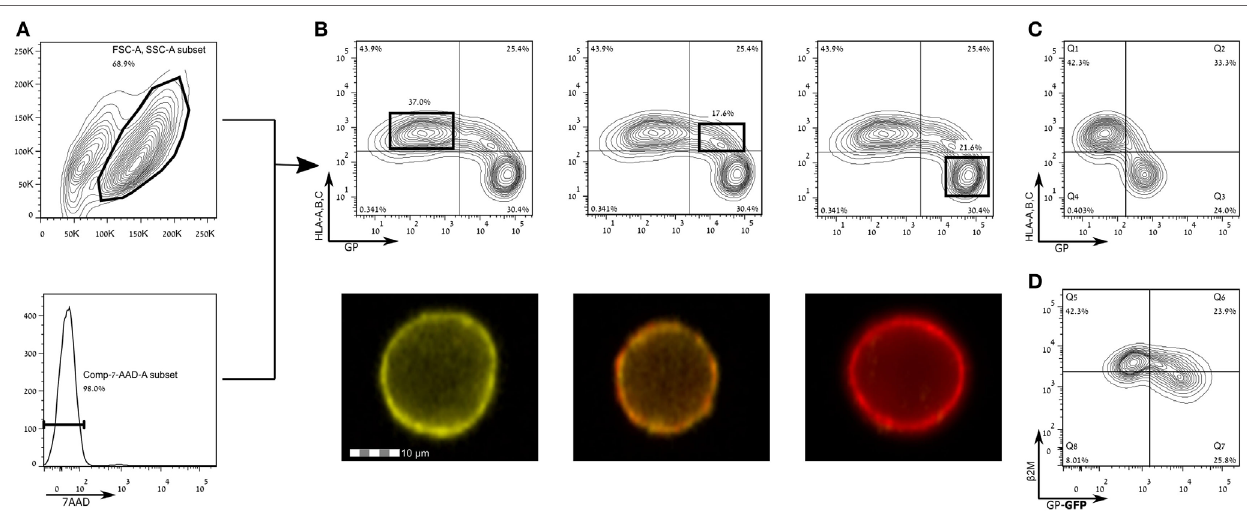
FigUre 2 | Expression of Sudan virus (SUDV)- and Makona-GPs results in loss of surface staining of HLA-A, B, C. The figure shows flow cytometry analysis of steric shielding of HLA-A, B, C antigens by Ebola GP. (a) SUDV-GP transfected HEK293T cells were harvested using a non-enzymatic reagent, and dead cells were excluded by 7-aminoactinomycin D. (B) Cells were stained for SUDV-GP with a biotinylated 3C10 antibody, followed by allophycocyanin-conjugated streptavidin, and co-stained for HLA-A, B, C surface antigens with a phycoerythrin-conjugated W6/32 antibody. Representative examples are shown in image stream fluorescent microscopy (Yellow: HLA-A, B, C. Red: SUDV-GP). (c) Makona-GP-transfected cells stained for expression of Makona-GP and co-stained for HLA-A, B, C surface antigens. (D) SUDV-GP-GFP transfected cells were stained for β 2 microglobulin. Results for (c,D) are from one representative experiment of two performed. Dot plot results shown in (B) are from one representative analysis of 30 independent flow cytometry